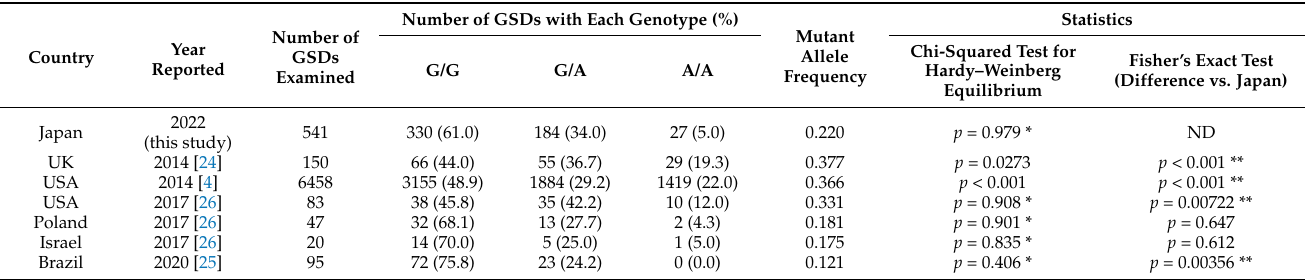
Fisher’s Exact Test (Difference vs. Japan)